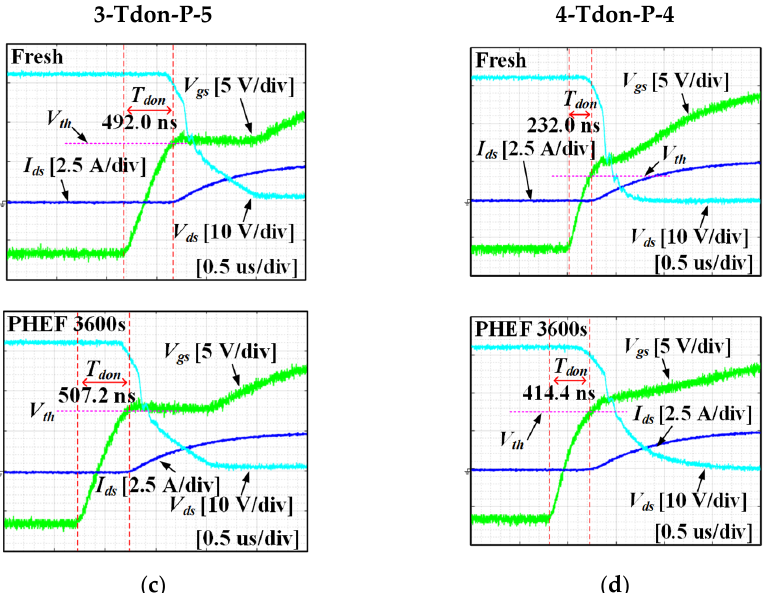
Figure 12. Turn on waveforms in PHEF stress: ( a ) 1-Tdon-P-1, ( b ) 2-Tdon-P-2, ( c ) 3-Tdon-P-1, and ( d ) 4-Tdon-P-4.